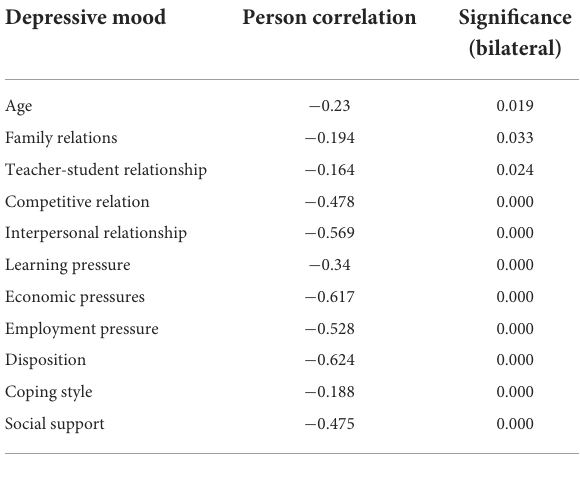
TABLE 5 Correlation analysis of depression emotion.